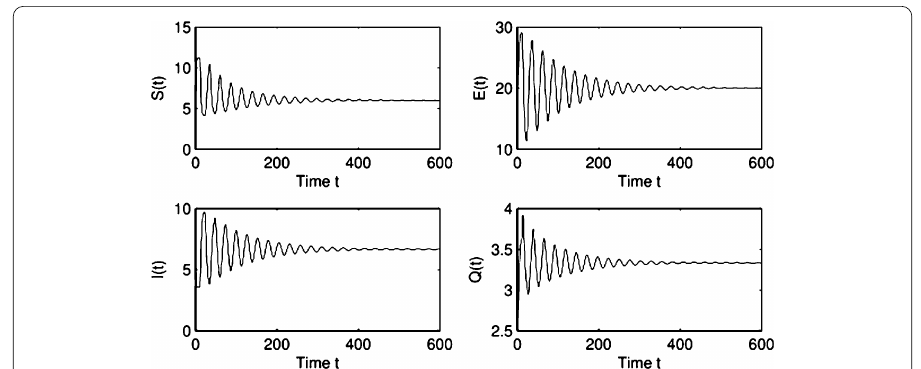
Figure 5 P ∗ is locally asymptotically stable when τ = 10.65 < τ 0 = 13.9858